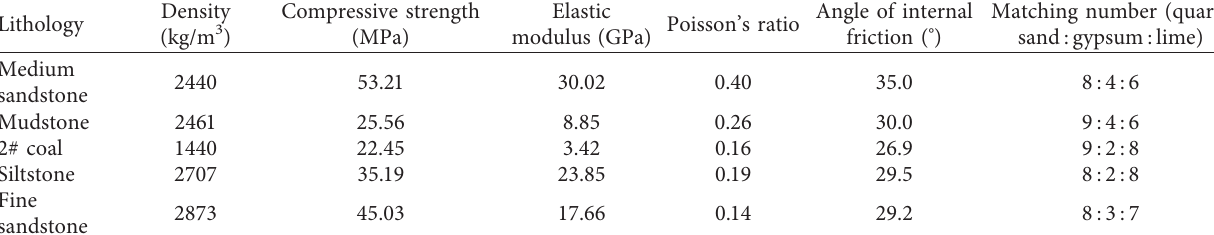
Table 1: Similar model lithology